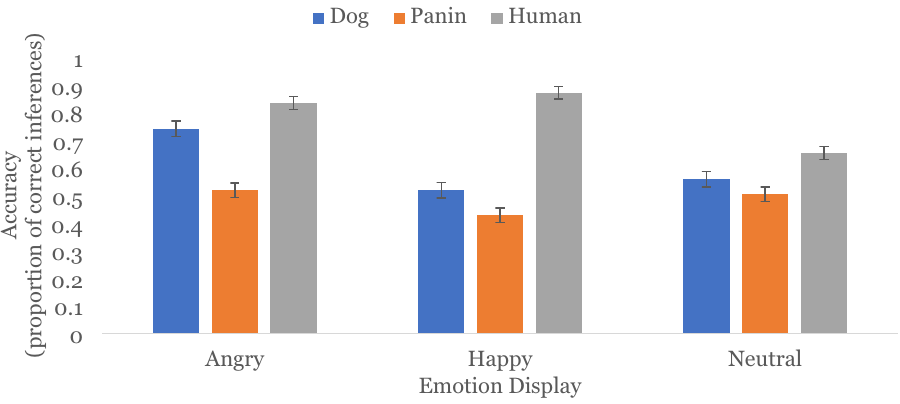
Figure 2. Proportion of accurate emotion inferences from facial displays in Study 2. Error bars represent standard error. All bars within emotion category are significantly